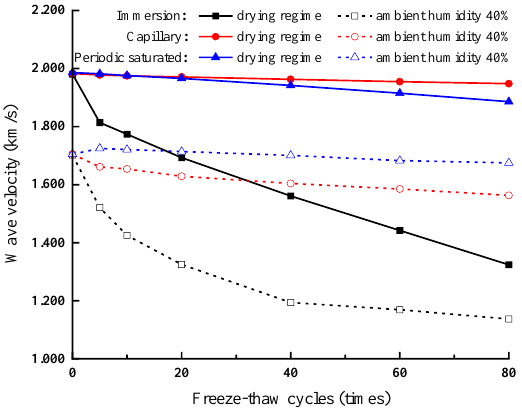
Figure 12. Wave velocity of rock samples under different test conditions.